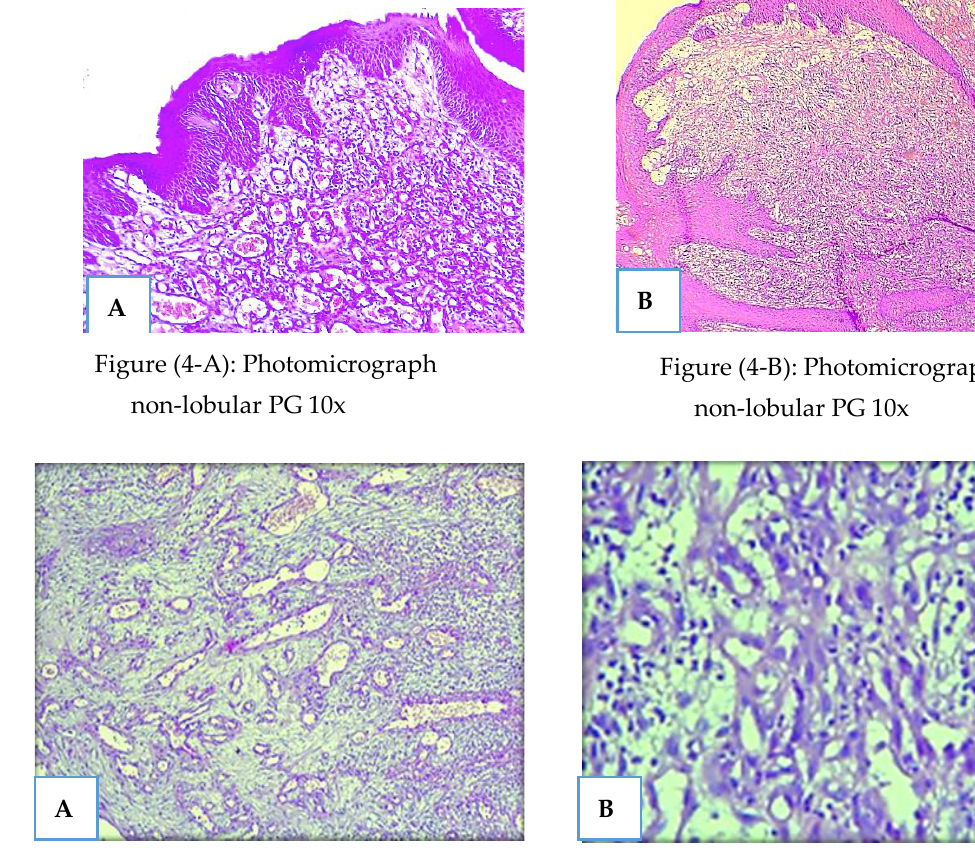
Figure (5-B): Photomicrograph non-lobular PG